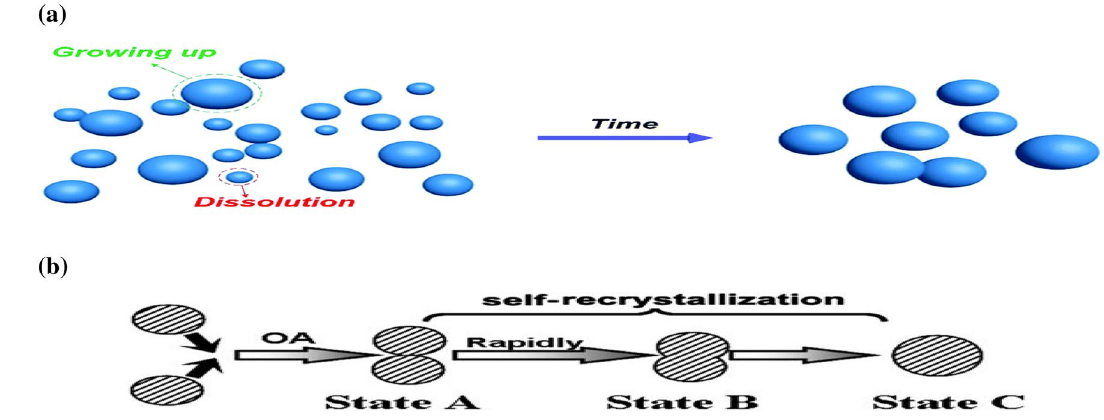
Fig. 3 Scheme of nanoparticle growth controlled by: a Ostwald ripening mechanism; b oriented attachment mechanism created based on the research by Kyoung-Ku et al.